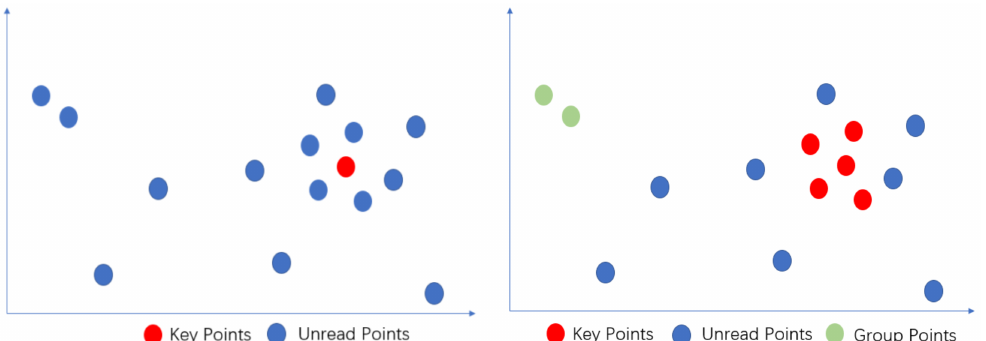
Figure 2. Categories of points